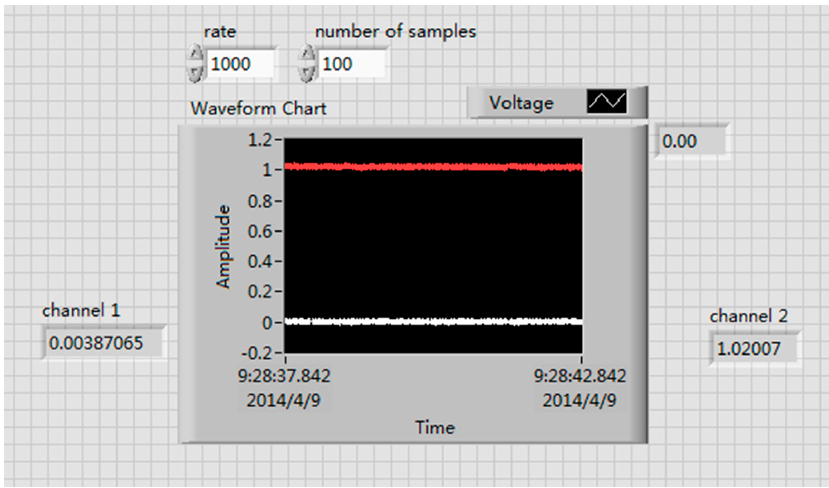
Figure 12. LabVIEW program.